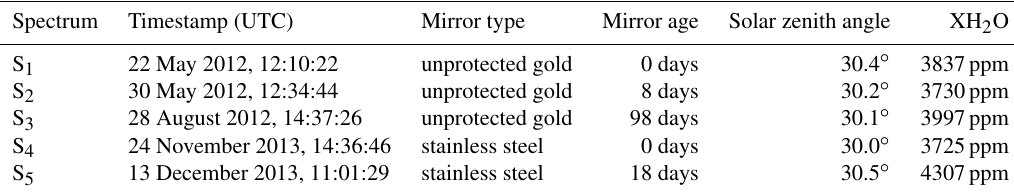
Table 3. Spectra used in the field intercomparisons in Sect. 4. Mirror age is time since mirror installation for S 1 , S 2 , and S 3 and time since last mirror cleaning for S 4 and S 5 .